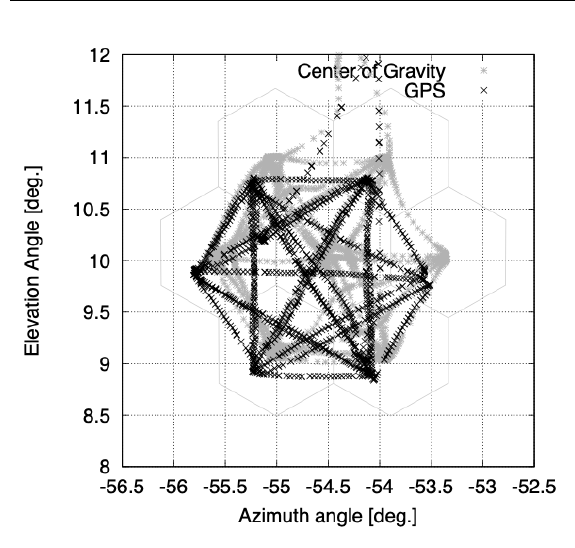
Figure 11. Measurement position by RTK-GPS on FD viewing field (Gray) and center of gravity of detected light by FD (Light gray).